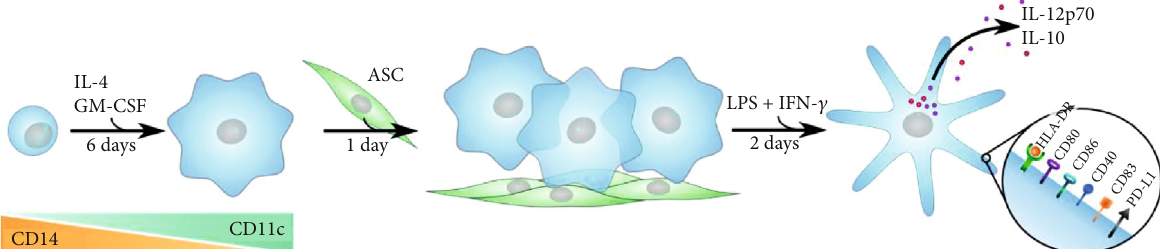
Figure 1: Experimental overview. Monocytes were isolated based on CD14 expression and induced to di ff erentiate into immature dendritic cells by IL-4 and GM-CSF. Following 6 days of di ff erentiation, small irregular dendrites were present. At this point, cocultures with ASC were established and allowed to recover for 1 day. The cocultures were matured by stimulation with LPS and IFN- γ for 2 days, supernatants were harvested and sampled for IL-12p70 and IL-10, and mature dendritic cells were analyzed for surface markers CD11c, HLA-DR, CD80, CD86, CD40, CD83, and PD-L1.